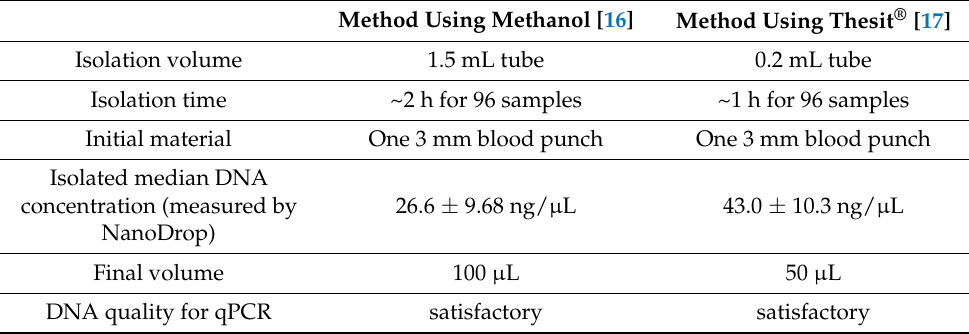
Table 2. Comparison of two DNA isolation methods for 20 DBS samples.